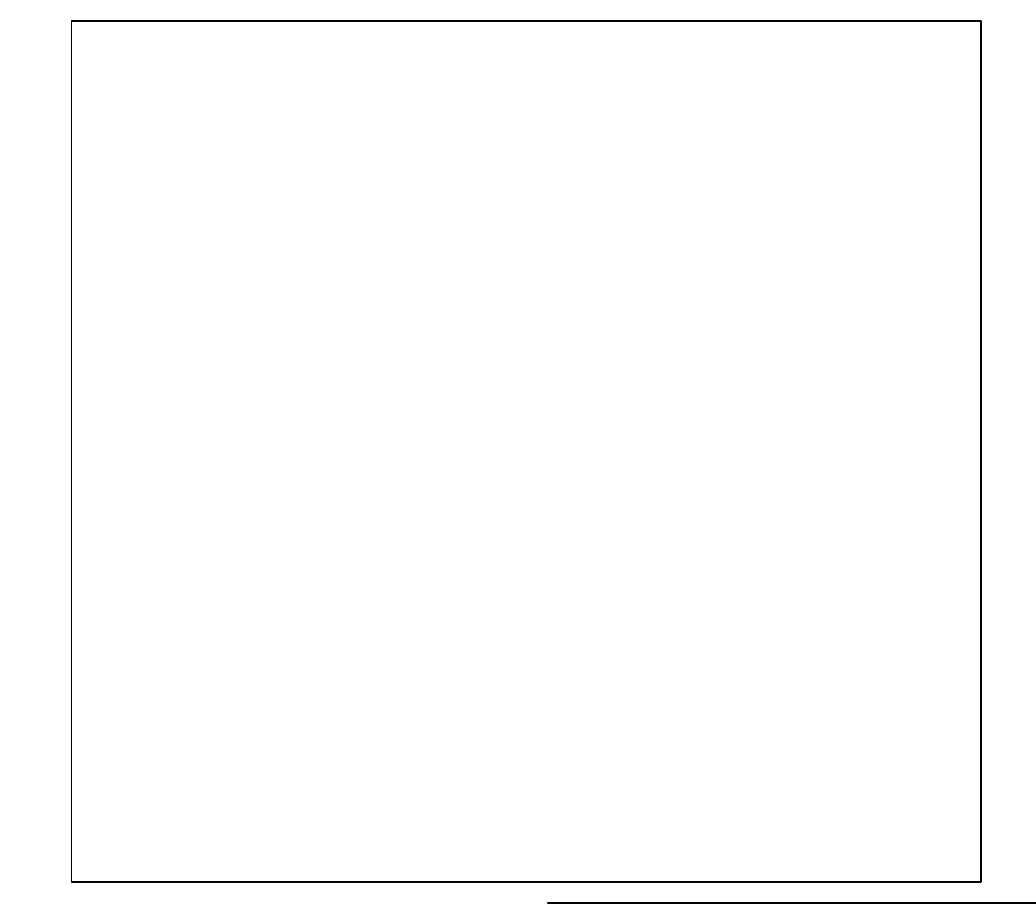
Table 1 : OSPE in pharmacology